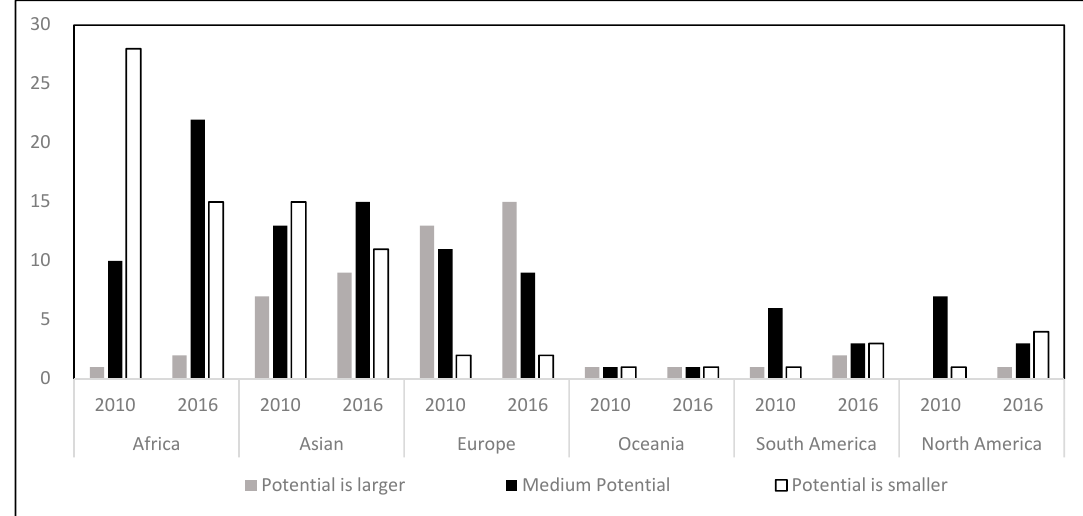
Figure 5. Distribution of economic conditions within “the belt and road initiative” countries. As shown in Figure 6, the deterioration of the political environment in African coun- tries between 2010 and 2016 has led to low potential for investment in arable land in most countries. Asia also has a more significant portion of countries with less potential for in- vestment in the political environment and still has more room for improvement. The po- litical environment in European countries has always remained relatively good, with most countries having average and above arable land investment potential. Figure 6. Distribution of political environment within “the belt and road initiative” countries. 3.3. Investment Potential Value of Arable Land The fuzzy C-mean clustering method provides a comprehensive cluster of 119 coun- tries’ arable land investment potential by size but cannot derive the specific potential value of each country and its ranking [83]. Therefore, the study uses the entropy weighting method to analyze further and assign weights to each indicator to calculate the potential value and provide relevant data for studying the spatial correlation of arable land invest- ment potential, as suggested by Lu and Huang [84]. By calculating each indicator of arable